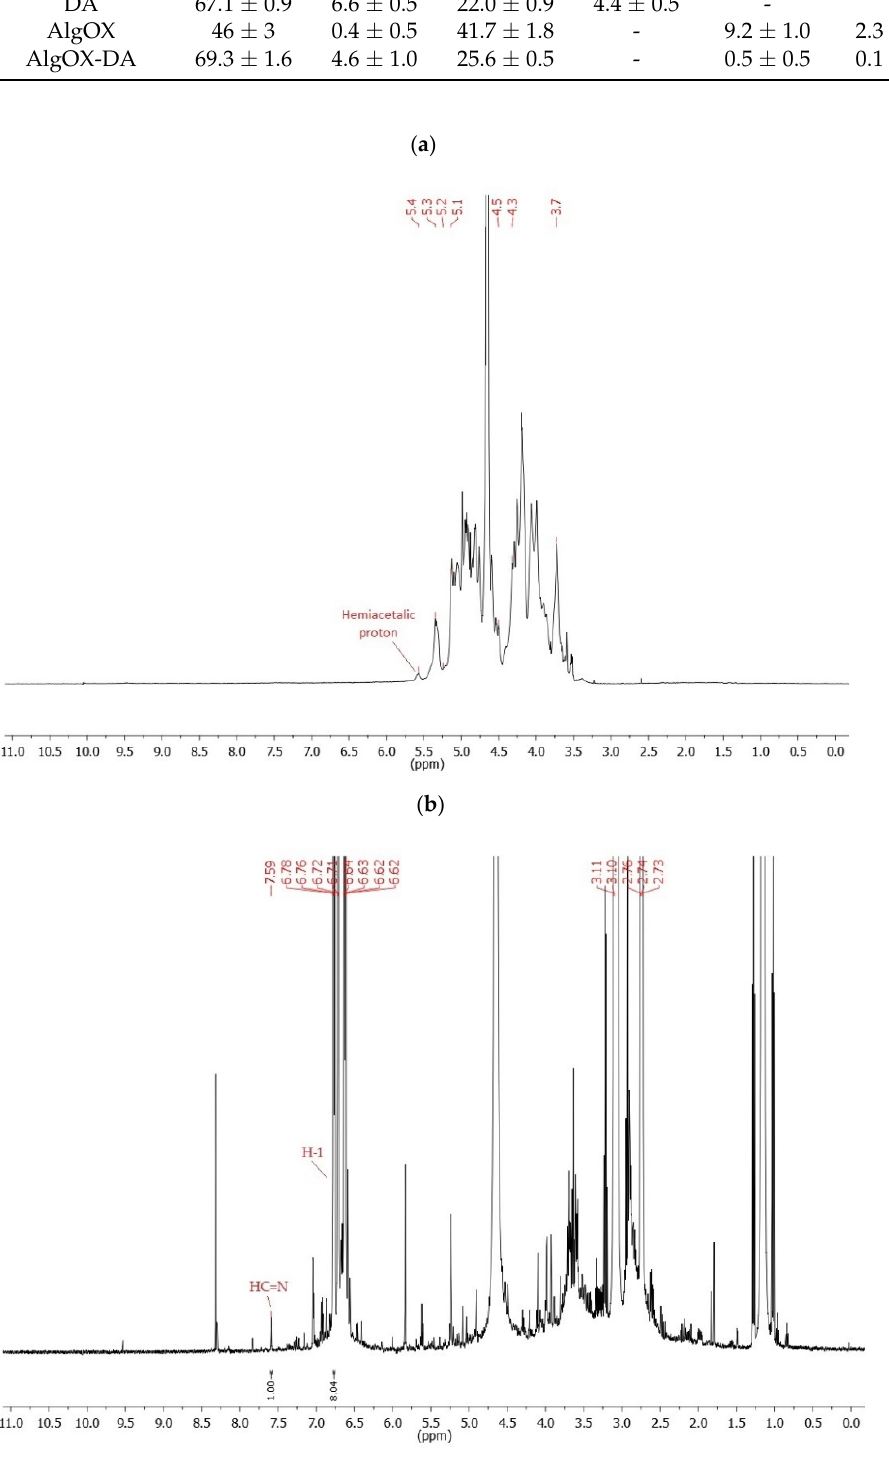
Figure 7. ( a ) 1 H NMR spectrum of AlgOX in D 2 O at 40 °C with identification of the main signals; ( b ) 1 H NMR spectrum of AlgOX-DA in D 2 O at 40 ◦ C with identification of the main ( b ) 1 H NMR spectrum of AlgOX-DA in D 2 O at 40 °C with identification of the main signals.